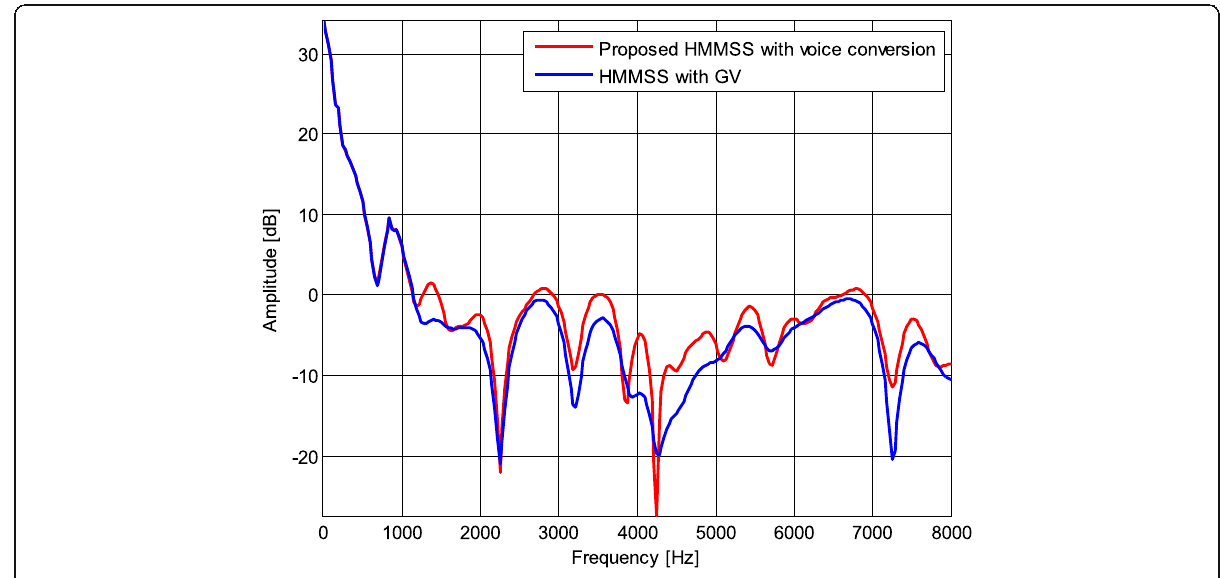
Fig. 4 Over-smoothness reduction for spectral